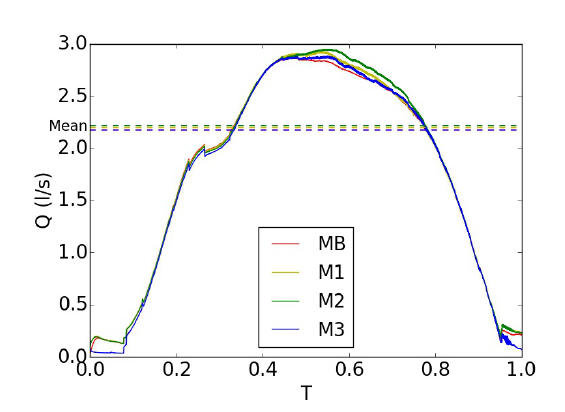
Figure 11. Flow rates for one oscillation cycle for different mesh resolutions MB–M3.